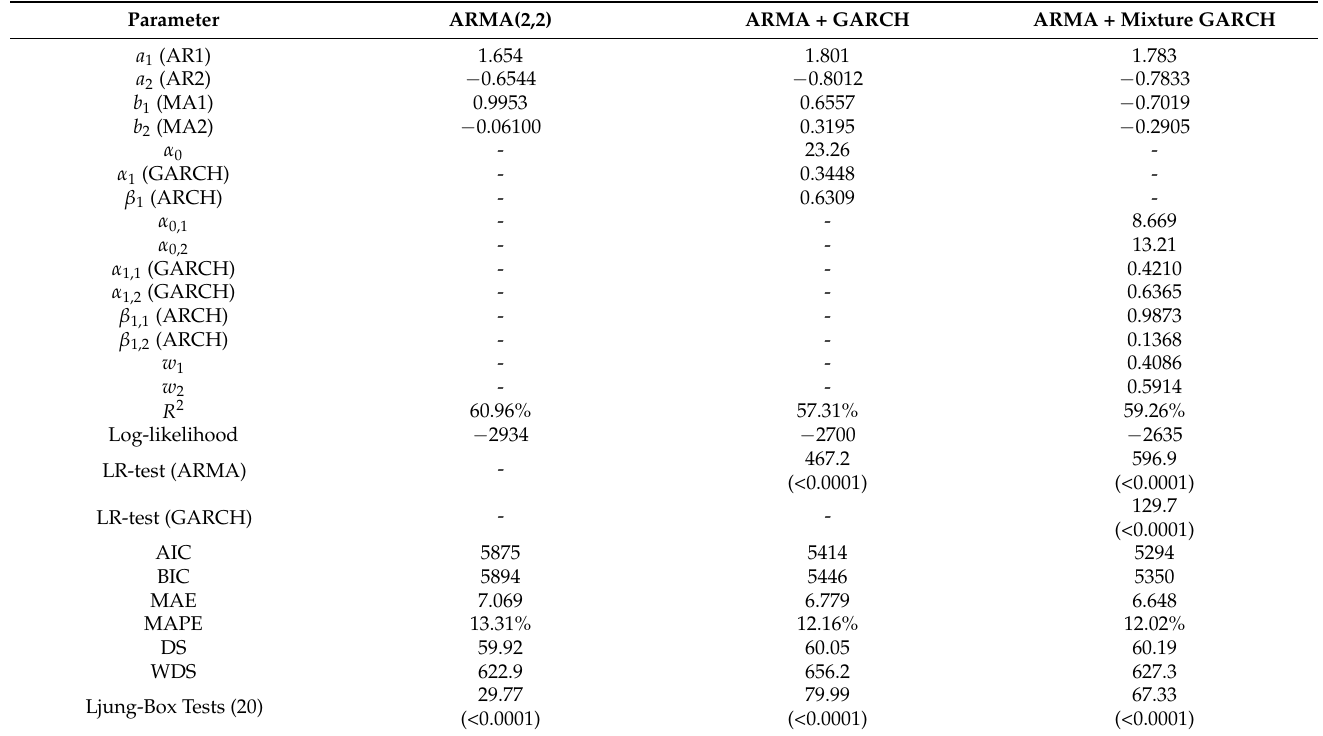
Table 8. Estimated parameters and performance measures for the second electricity price